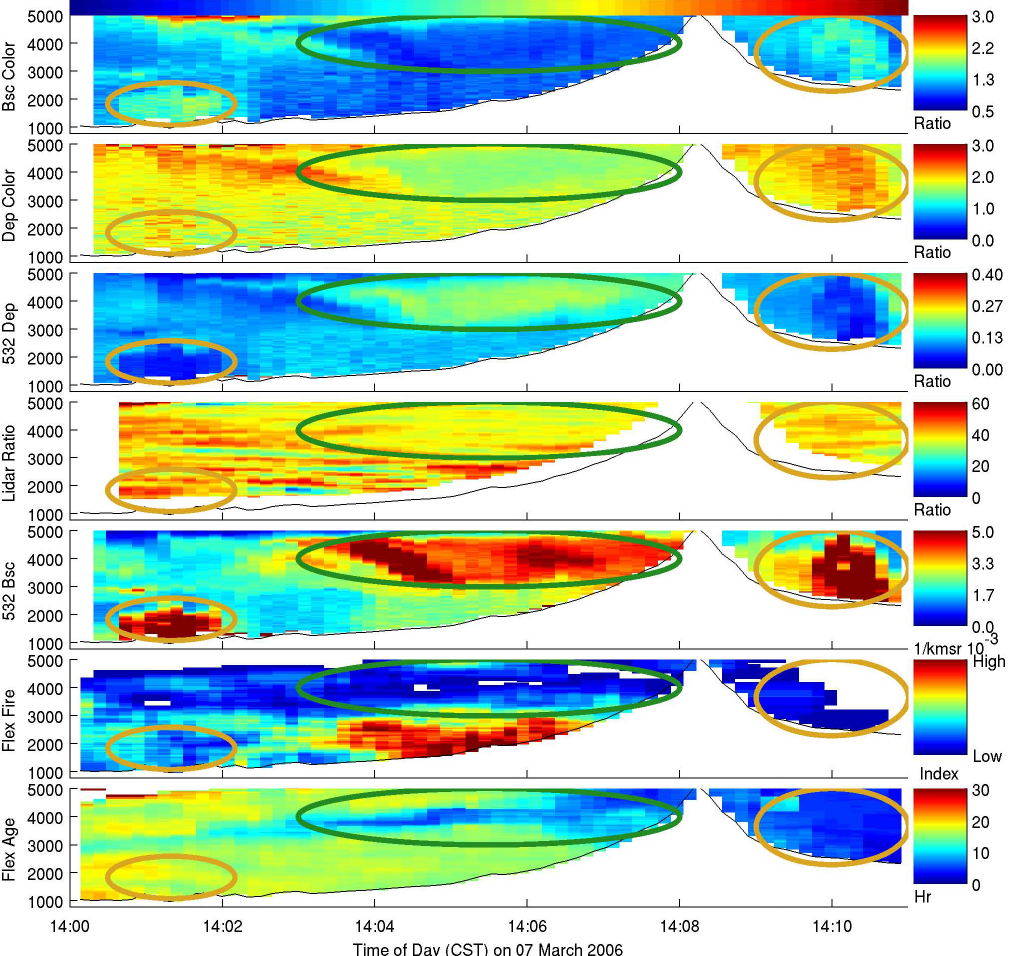
Fig. 4. Curtain plots of HSRL backscatter coefficients and intensive properties on 7 March 14:00 to 14:11 along with Flexpart mean age and particle count index for biomass burning tracers. Yellow ellipses show two fresh biomass burning plumes and the green ellipse shows the mixed urban plume transported by the gap flow. The y-axis is height above mean sea level. The location of the profile can be identified by matching the colorbar across the top with the flight paths shown in Fig.